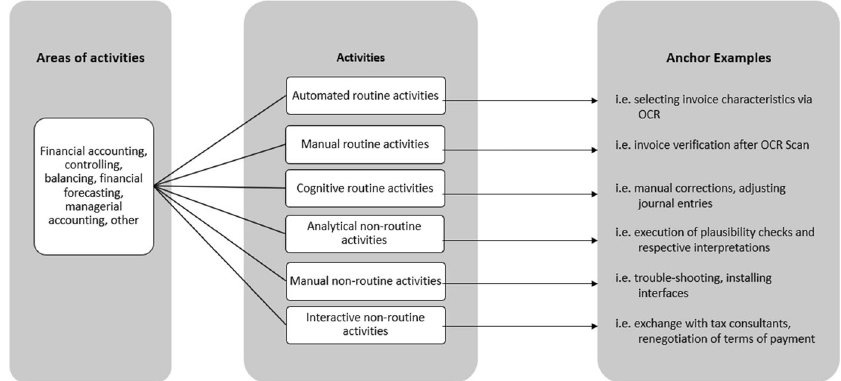
Fig. 4 Overview of the coding manual for accounting